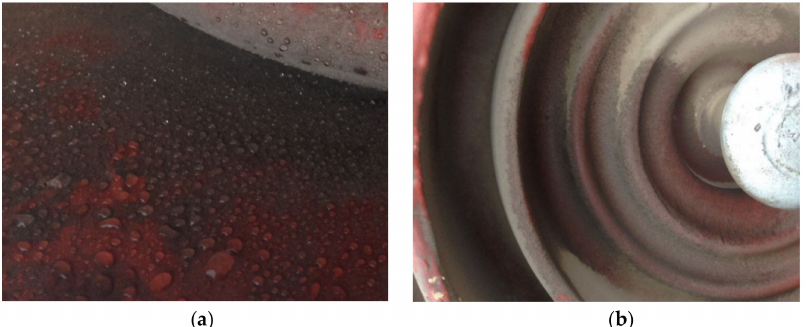
Figure 15. The hydrophobicity of the suspension insulator. ( a ) The upper surface; ( b ) the lower surface.